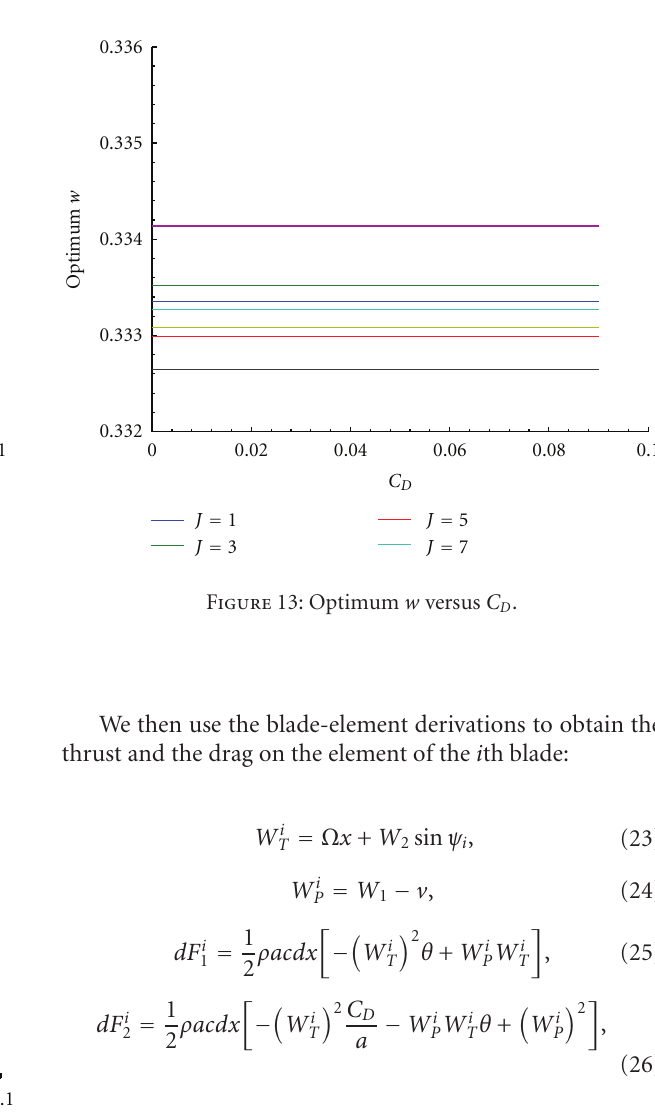
Figure 12: Optimum θ versus C D .